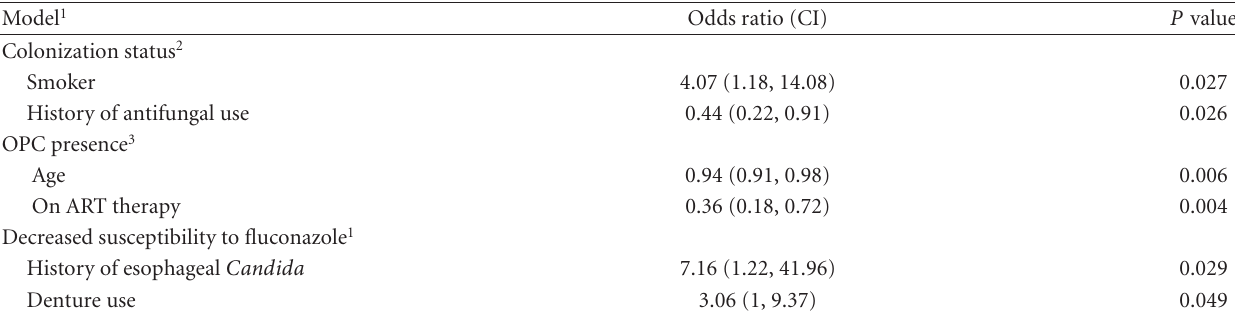
Table 2: Logistic models of di ff erent epidemiologic factors impacting OPC, colonization, and decreased susceptibility to